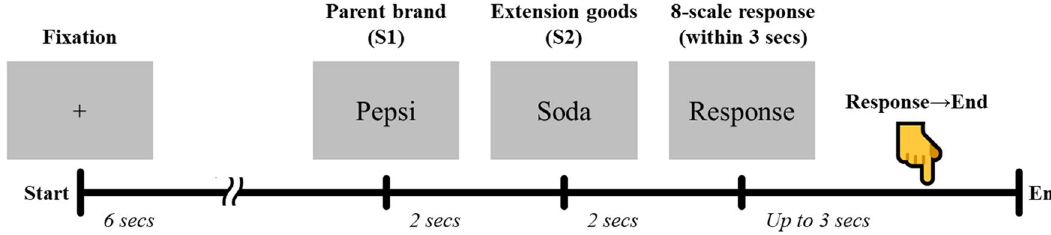
Figure 1. Experimental design (S1–S2 paradigm). Each trial began with the fixation point of 6 s. In next, parent brand name (S1) and extension goods name (S2) were presented successively for 2 s each. Participants were